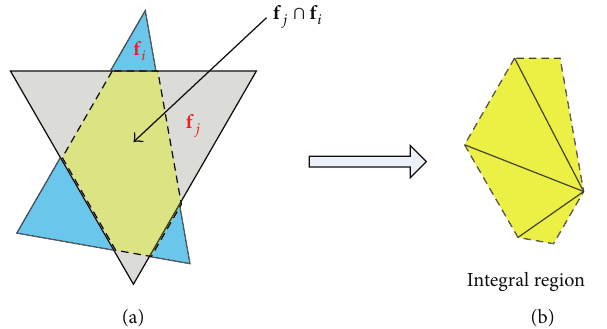
Figure 4: (a) An example of the nonconformal patches on the interface. (b) The description of evaluation of the cement matrix (union mesh).